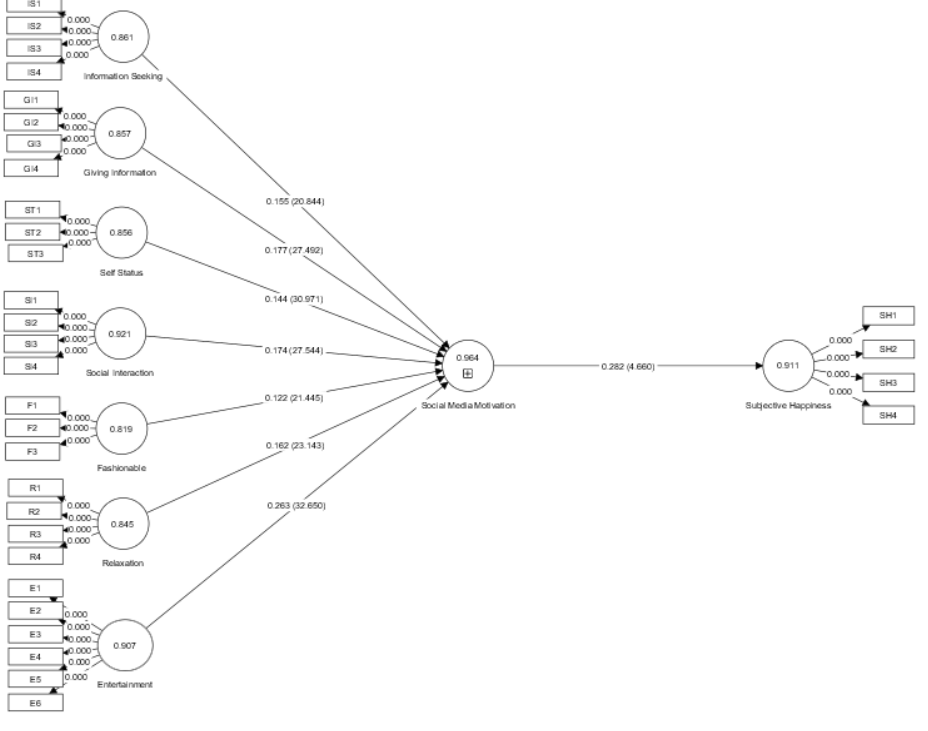
Figure 2. Structural model assessment.